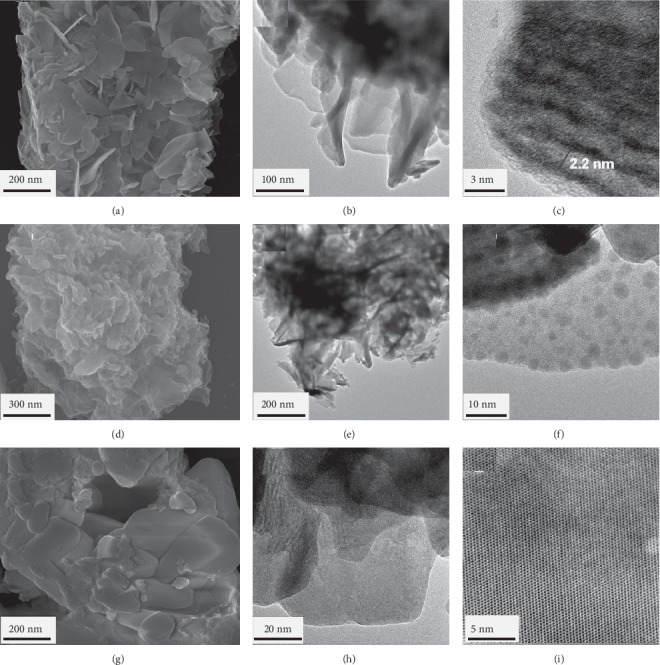
SEM image (first column) and HRTEM images (second and third columns) for Dy2(OH)5(C28H20O6S2)0.5.nH2O (a–c), Dy2(OH)5 (C28H20O6S2)0.5@Cu.nH2O (d–f), and Dy2(OH)5 (C28H20O6S2)0.5@Pb.nH2O (g–i).